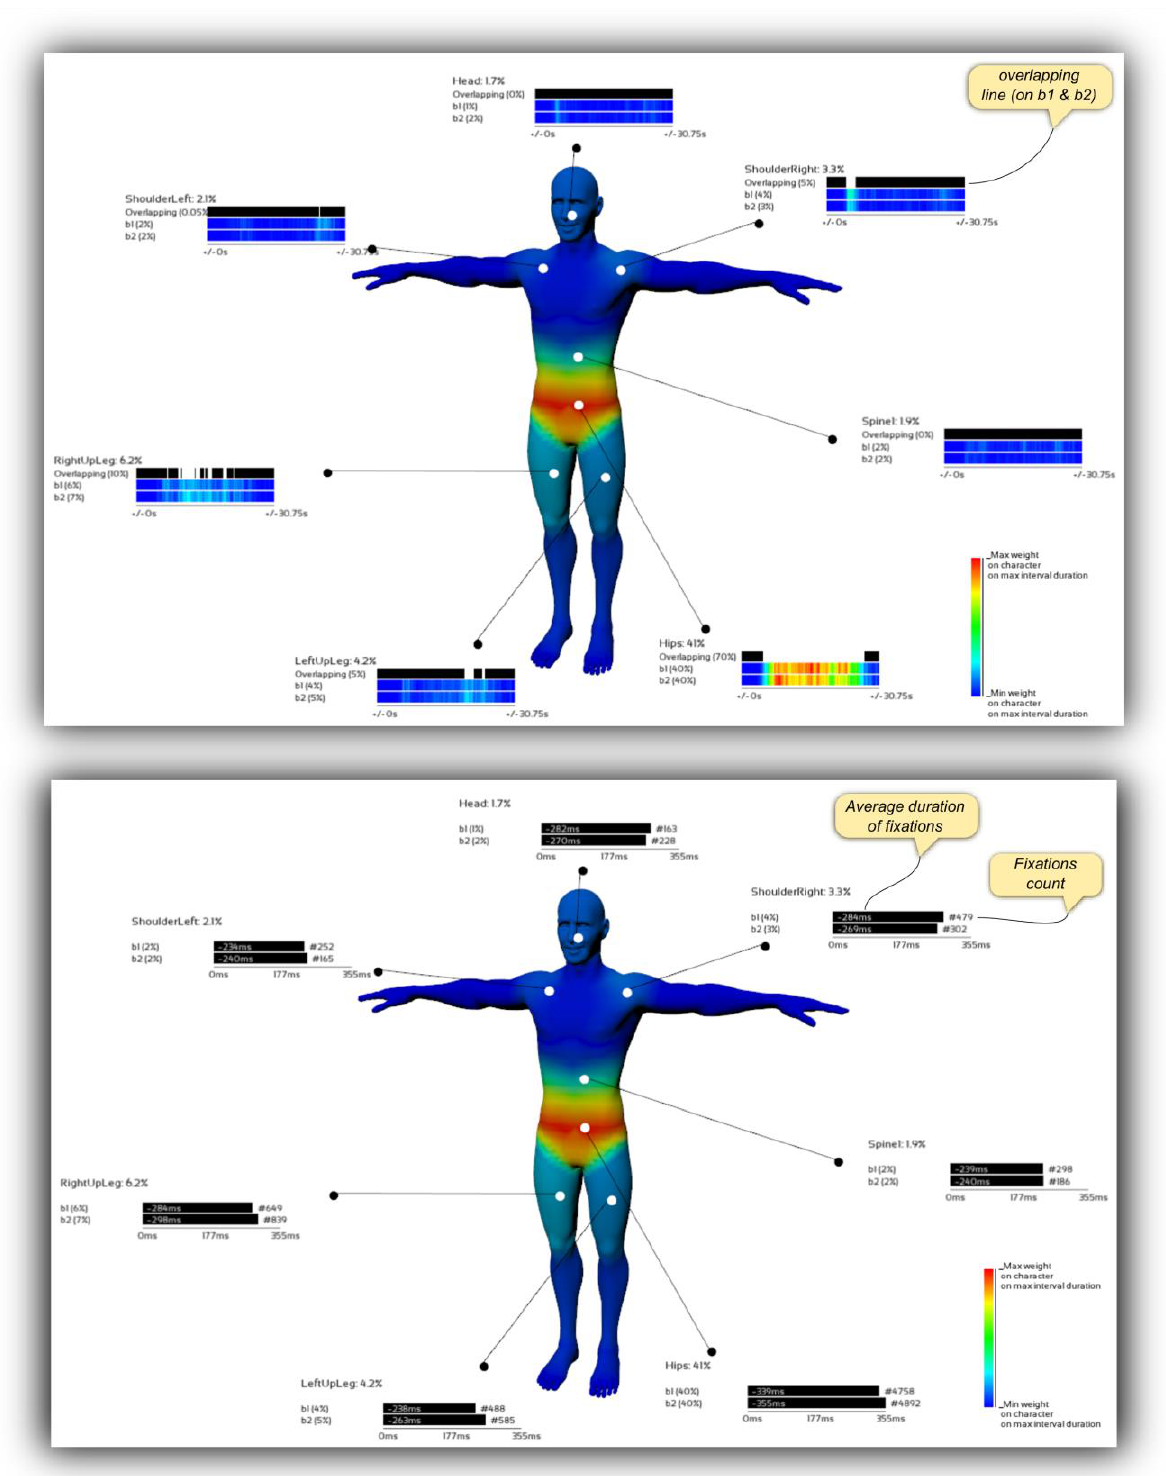
Figure 8. Gymnastic judgment . Top: Illustration of gaze distribution average for the two groups of judges (level B1 and B2). Bottom: Illustration of viewers' fixations for each group of